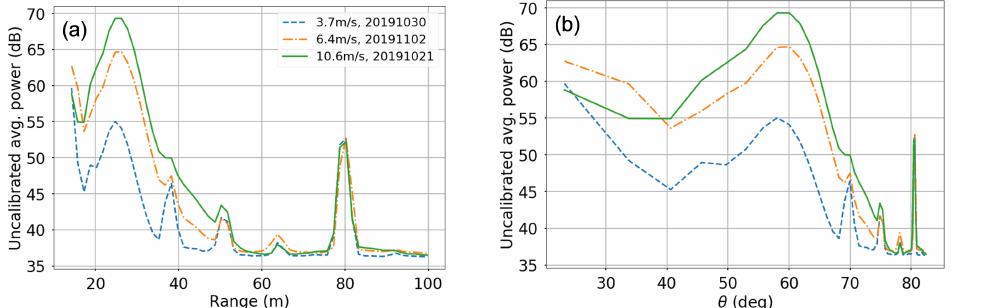
Figure 3. Uncalibrated power with respect to radar range ( a ) and incidence angle ( b ). Data cor- responding to three different wind speed conditions are shown: 3.7 m/s (dashed-blue), 6.4 m/s (dot-dashed orange) and 10.6 m/s (solid